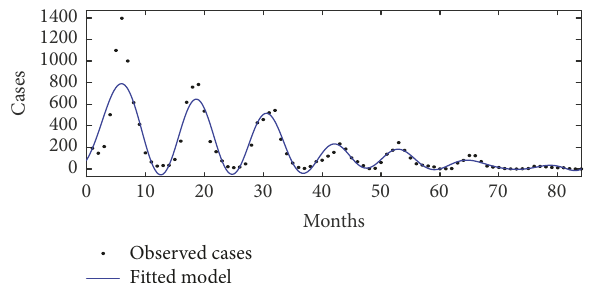
Figure 2: The monthly numbers of new Guinea worm cases and its fitted